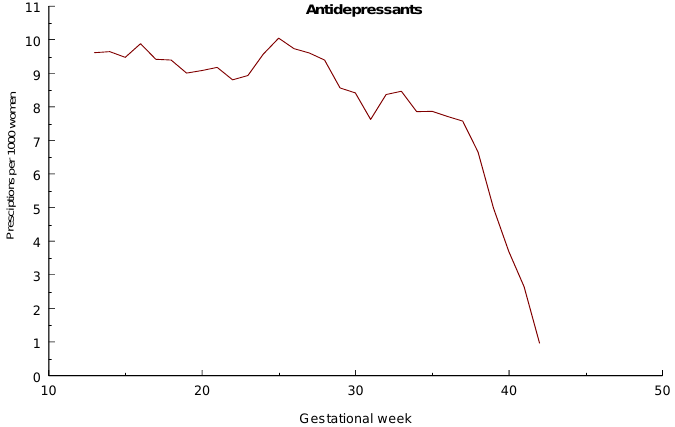
Figure 6. Diagram showing number of women per 1,000 who had filled a prescription for an antidepressant for each gestational week.